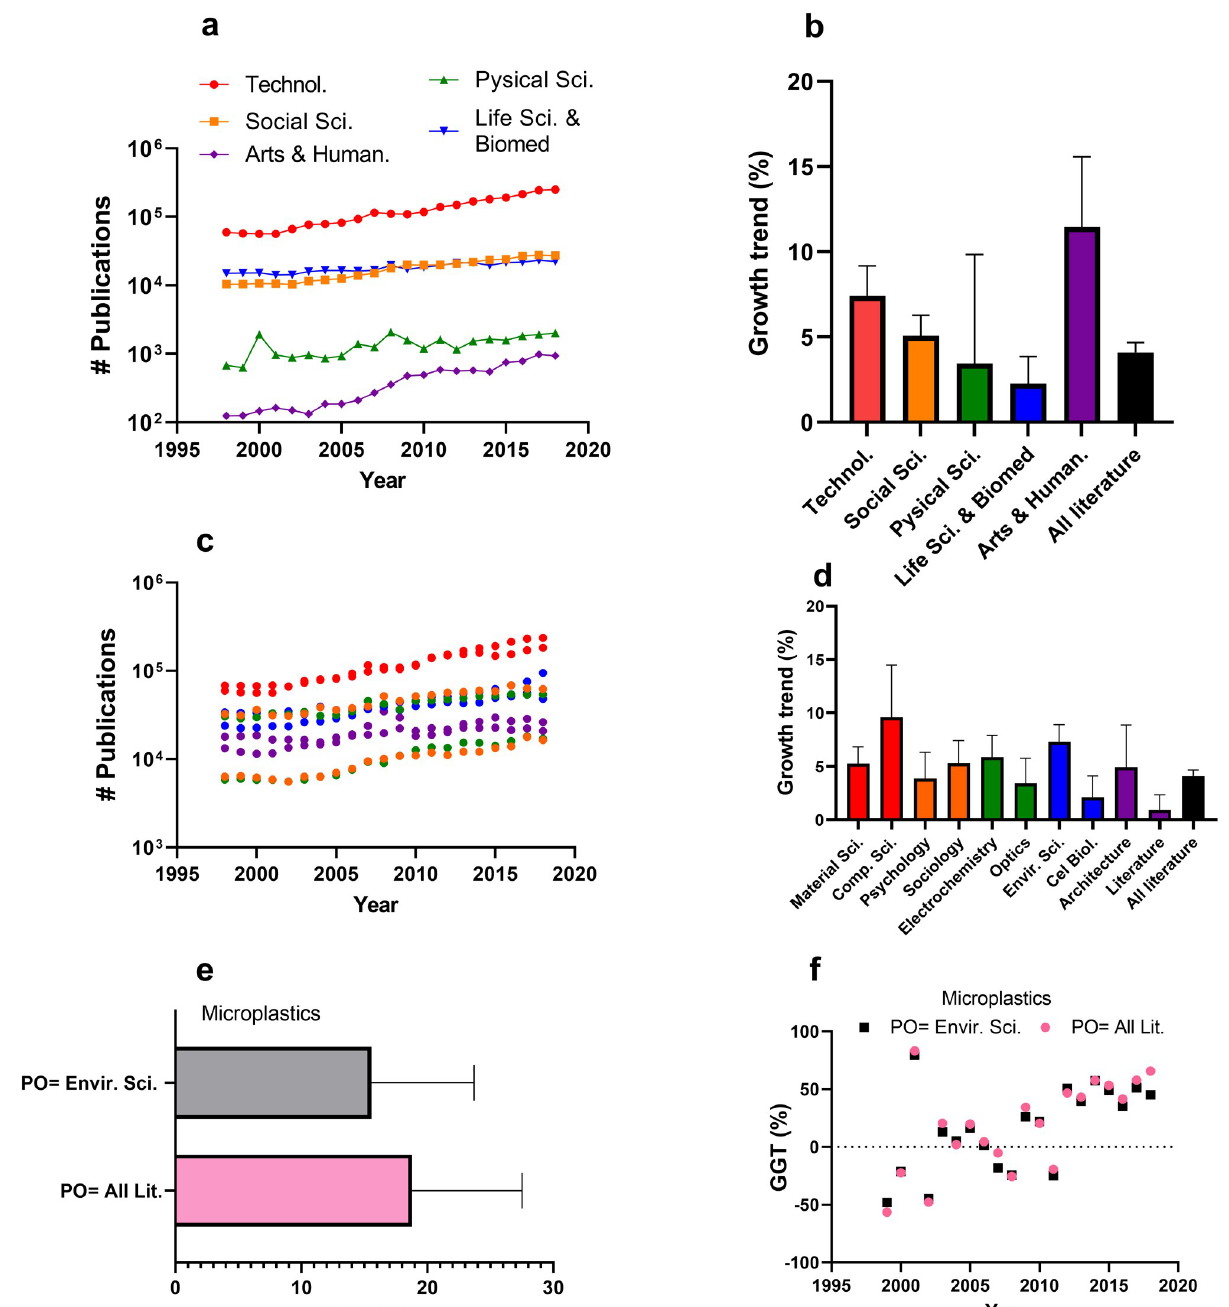
Fig 5. Alternative growth rate corrections. (a) shows total publication output for the five main research areas specified in WoS and (b) shows the growth rate calculated for those areas over the 2018–1998 period. (c) shows the total publications for WoS research categories (two categories per research area). (d) shows the growth rate calculated for those categories over the 2018–1998 period. Panel colours are matched to the research areas indicated in (a). The ESCI index was excluded for all analyses. (e) Average GGTs for the microplastics field using all literature or the WoS research category “environmental sciences” as the PO. (f) Annual GGTs for the field microplastics using all literature or the WoS research category “environmental sciences” as the PO.